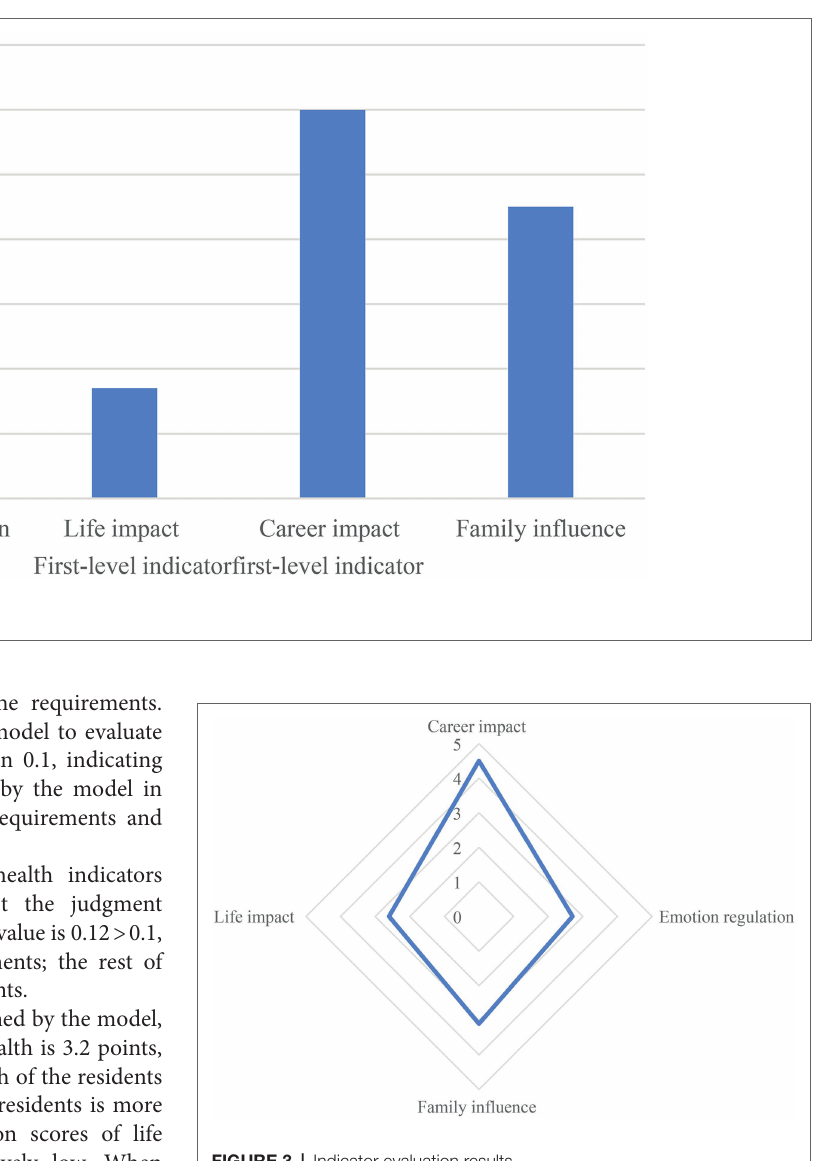
FIGURE 3 | Indicator evaluation